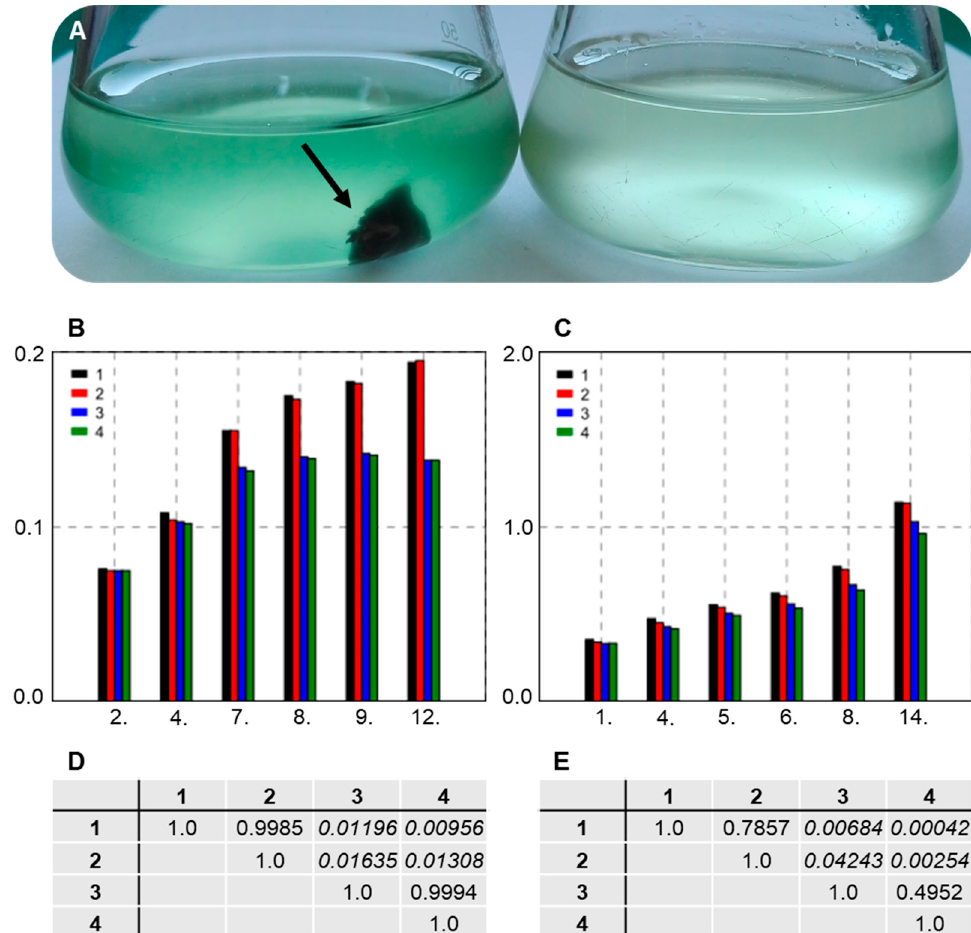
Figure 6. Cultivation of the cyanobacterial strain SAG 88.79 with or without the fungal strain AGSC12. ( A ) Co-cultures (left) and mono-cultures (right) of the SAG 88.79 strain in liquid Spirulina medium. A black arrow shows the hyphal batch in the medium. ( B , C ) Bar charts indicate the differences between the co- (sample 1 and 2) and mono-cultures (sample 3 and 4). The y-axles depict the OD values ( λ = 730 nm) and the x-axles show the days of sampling. The differences were significant in both cases (repeated-measures ANOVA, P = 0.001427 and P = 0.000232, respectively). ( D , E ) Tukey’s pairwise post-hoc test demonstrated that all the co-cultures exhibited significantly higher cyanobacterial growth than the mono-cultures did. As in ( B ) and ( C ), samples 1 and 2 are for the co-cultures, and samples 3 and 4 are for the mono-cultures. The values in the tables are the corresponding pairwise P -values. Italics show the significant values. The cyanobacterial strain SAG 88.79 attained higher cell density in the presence of the fungal strain AGSC12.